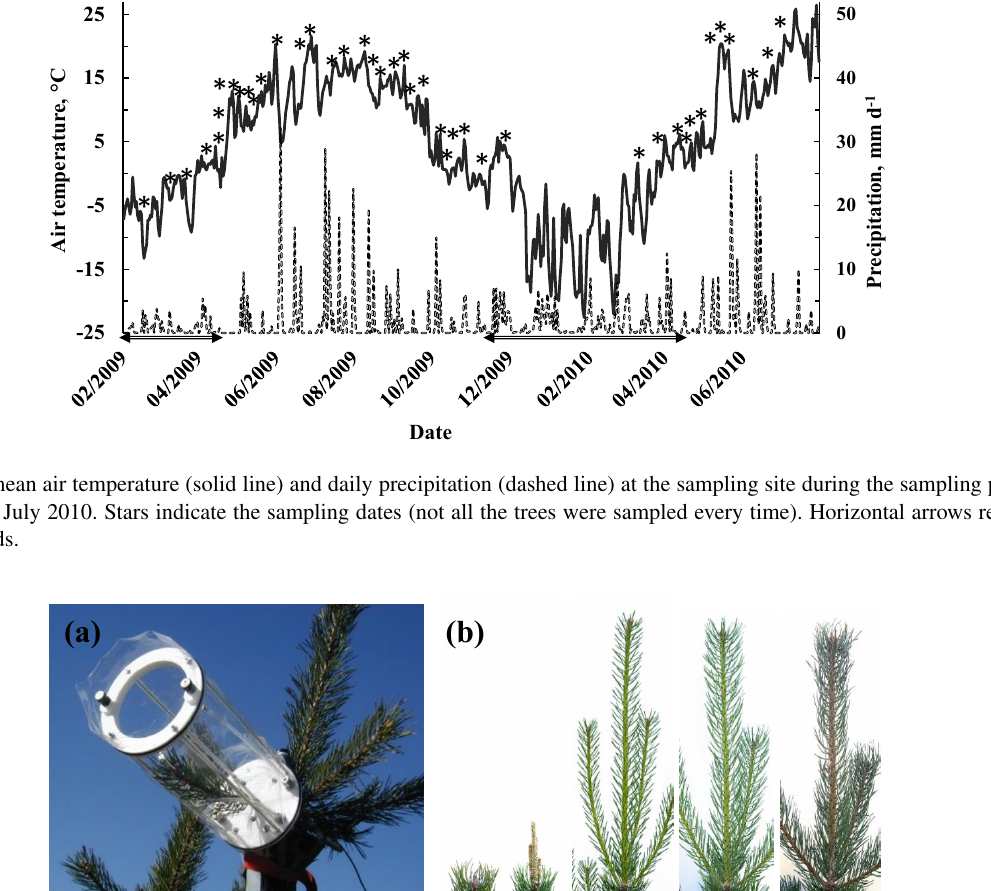
arylene siloxane capillary column (60m × 250µm × 0 .